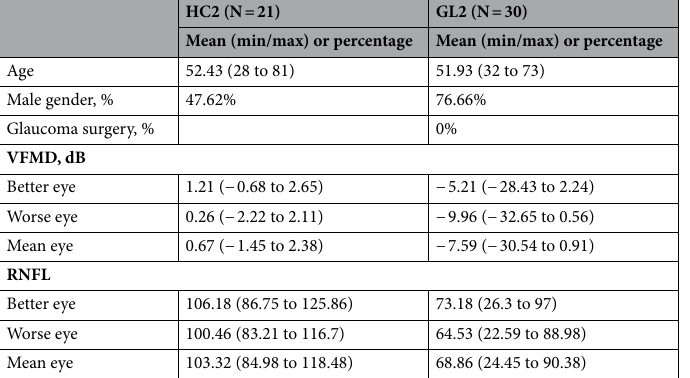
Table 2. Characteristics of Cohort 2 (collection site at Japan; JP). VFMD = mean deviation (dB), RNFLT = retinal nerve fiber layer thickness